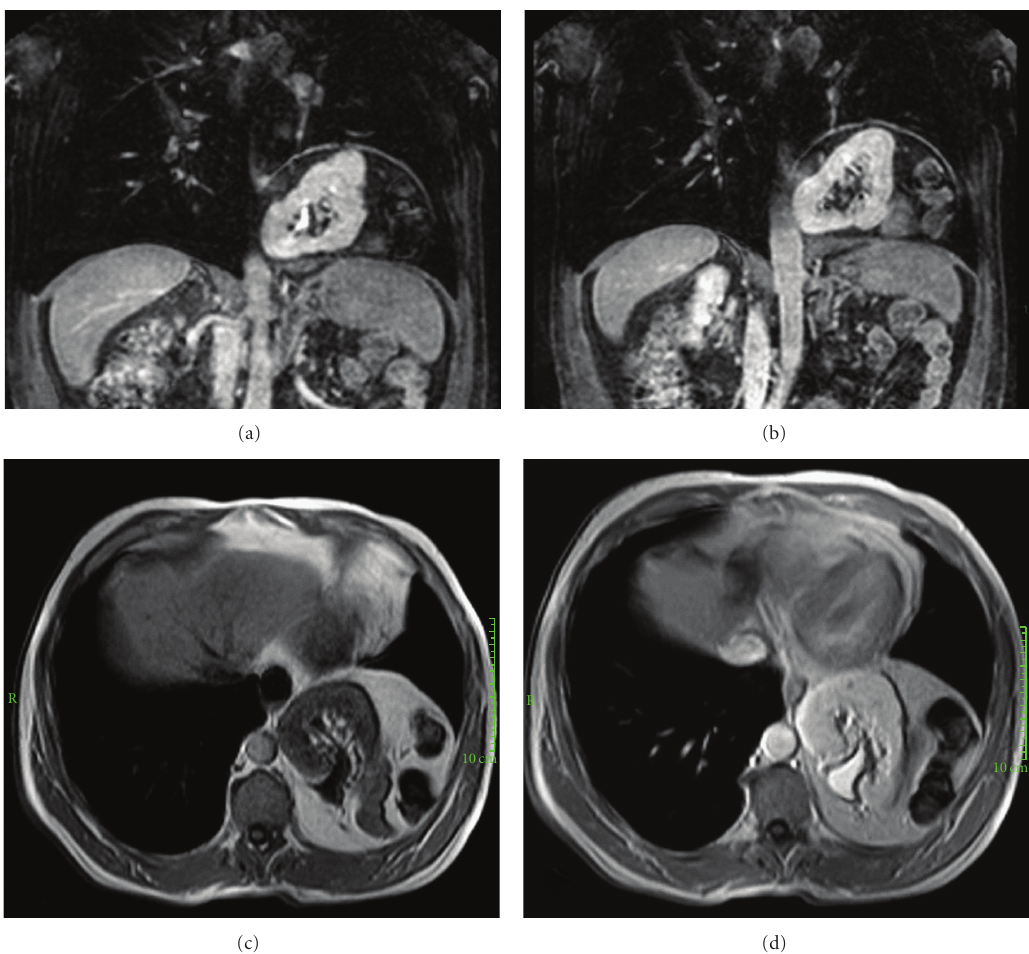
Figure 5: Magnetic resonance imaging (MRI). (a and b) THRIVE sequences with bolus of contrast medium injection; (c) axial T1-weighted sequence; (d) T1 post-Gd